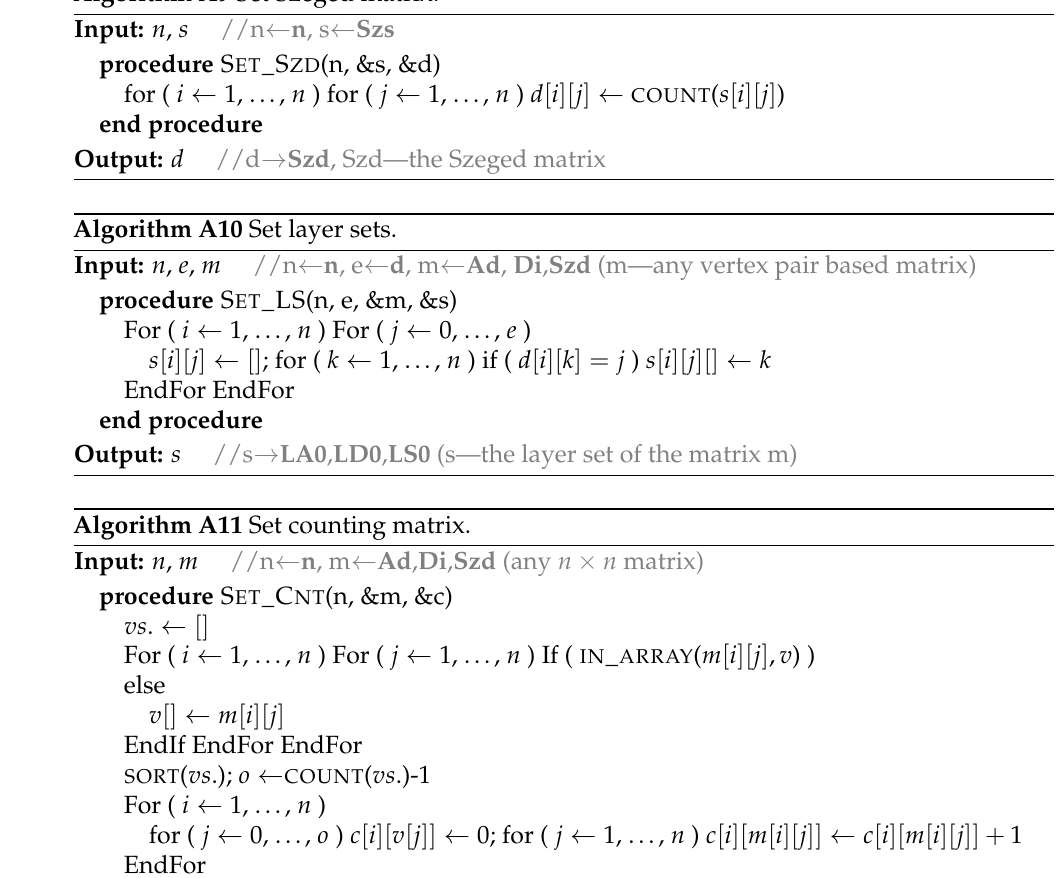
Algorithm A9 Set Szeged matrix.